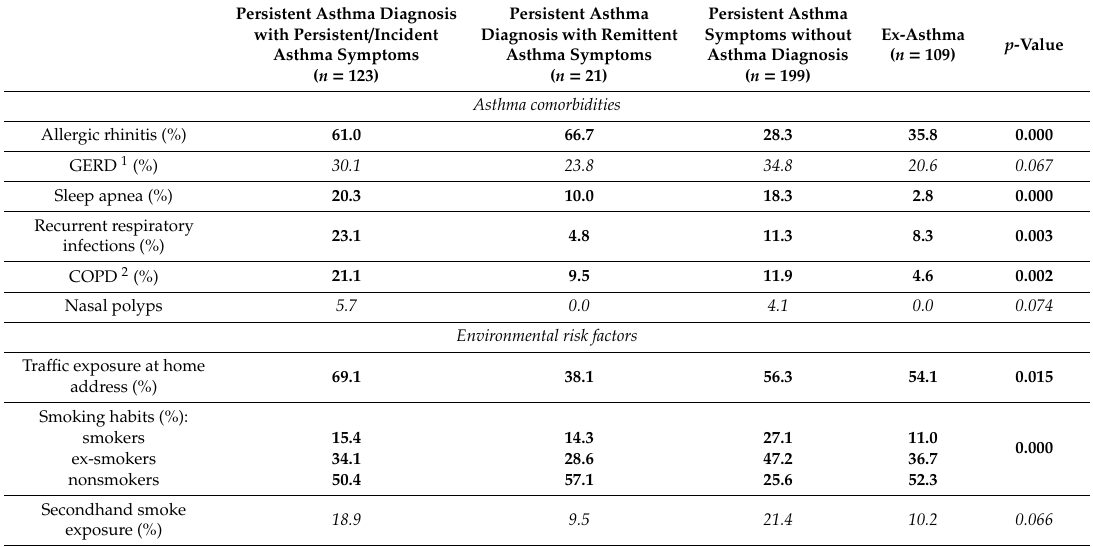
Table 6. Baseline host and environmental risk factors by longitudinal asthma